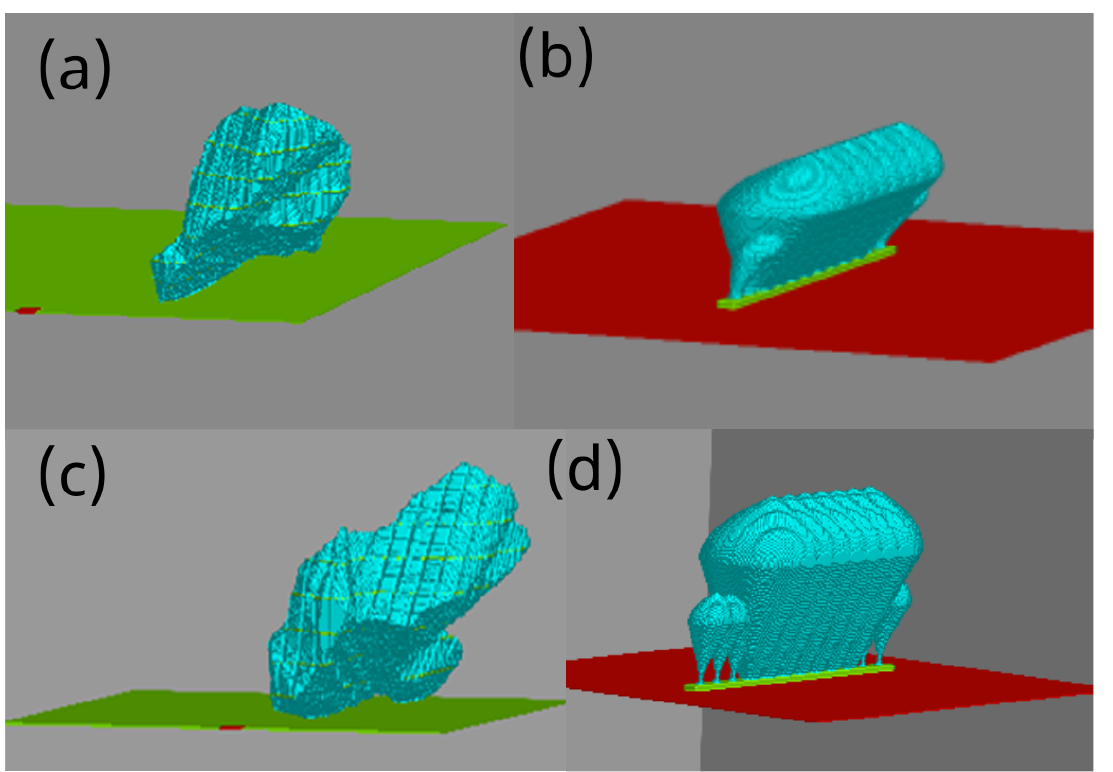
Figure 7. Comparison of a three-dimensional plume volume created from digital images to 12 over- lapping plumes simulated by the one-dimensional model. The number of on and o ff fans in ( a ) and ( b ) were 8 and 4, respectively, whereas 7 fans on and 5 fans o ff for ( c ) and ( d ).